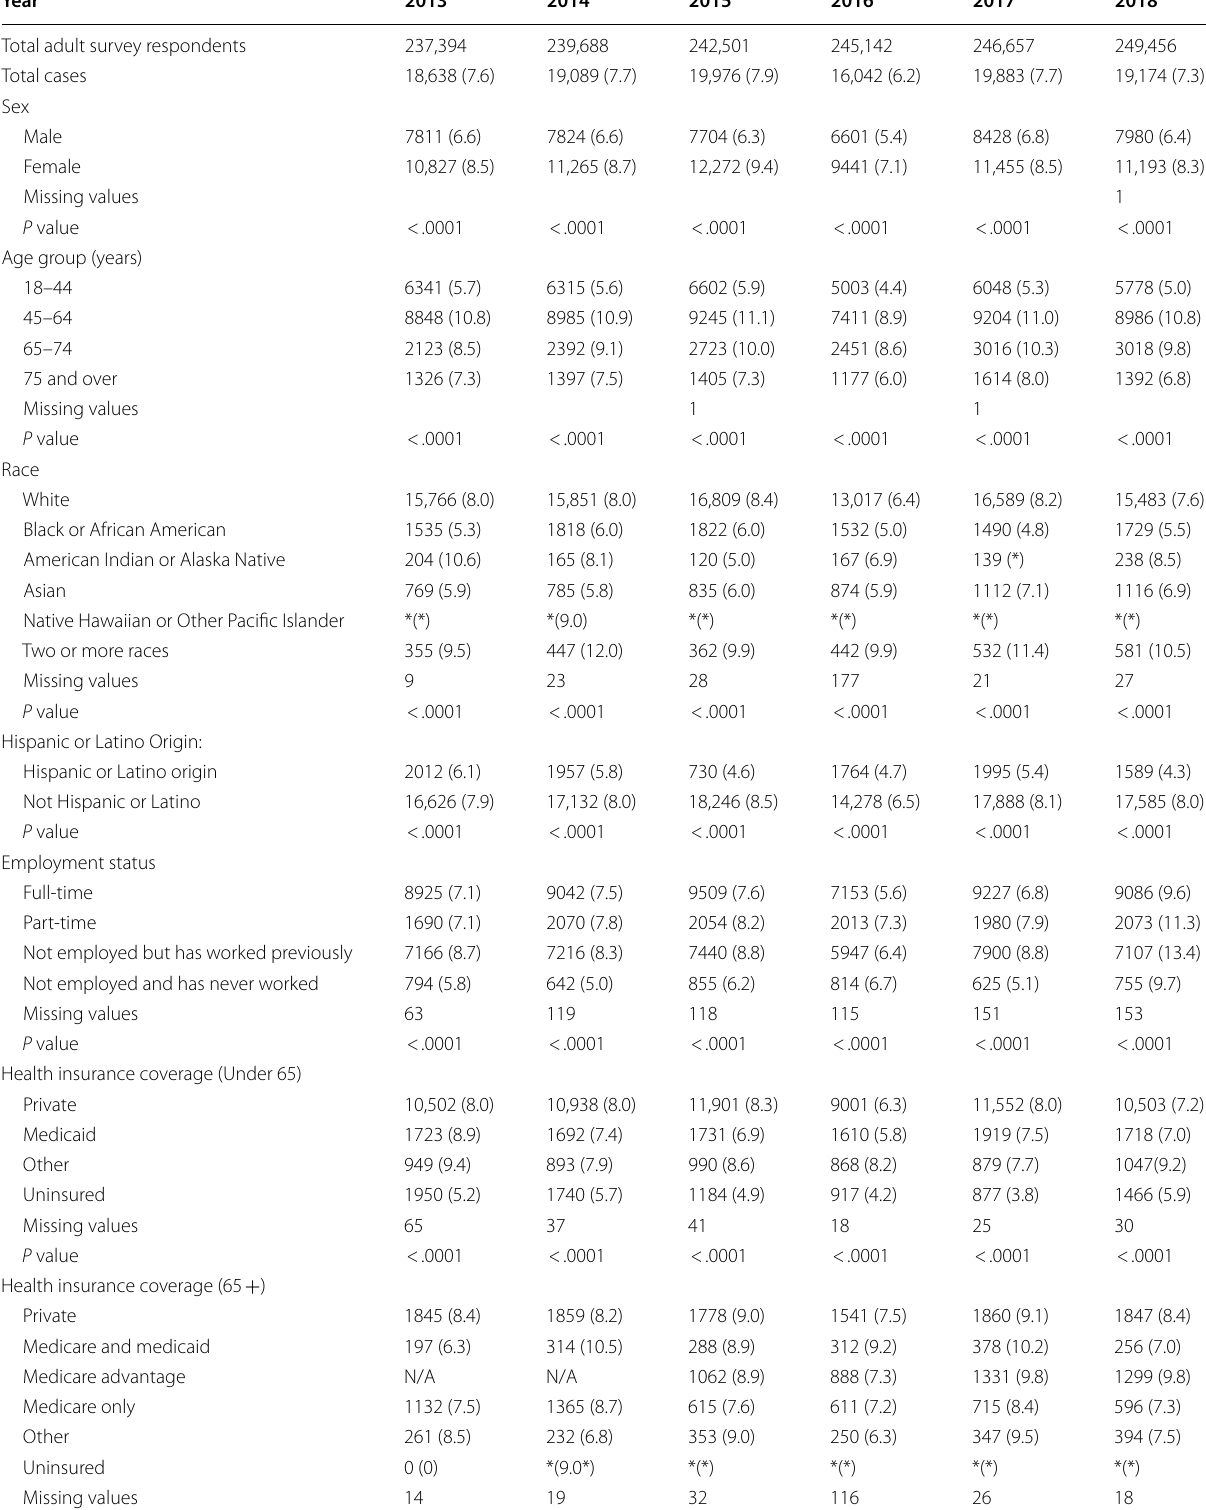
Table 1 Adult self-reported diagnosis of hay fever from 2013 to 2018 by frequency (in